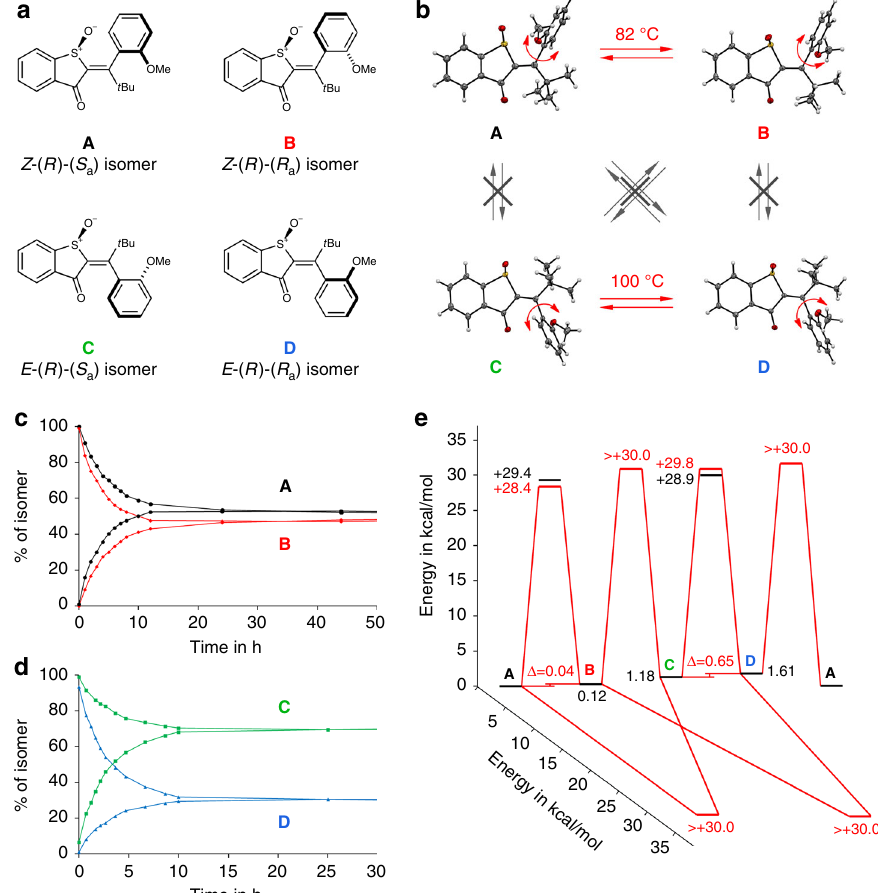
Fig. 2 Ground state energy pro fi le of HTI 1 . a Molecular geometries of the four stable isomeric states A to D of 1 . b Molecular structures of all four isomers of 1 obtained from crystal structural analysis and their slow thermal interconversions at high temperature (>80 °C). c Experimental fi rst order kinetics for thermal interconversion of atropisomers A and B (82°C) in (CDCl 2 ) 2 solution. d Experimental fi rst order kinetics for thermal interconversion of atropisomers C and D (100°C) in (CDCl 2 ) 2 solution. No thermal DBI occurs at elevated temperatures. The interconversion was quanti fi ed using 1 H NMR spectroscopy. e Ground-state energy pro fi le for 1 . Thermal conversion between the four different isomers at ambient temperature is prevented by very high kinetic barriers. Values in black are derived from quantum chemical calculations (B3LYP/6-311G(d,p), PCM(DCM)), values in red were determined